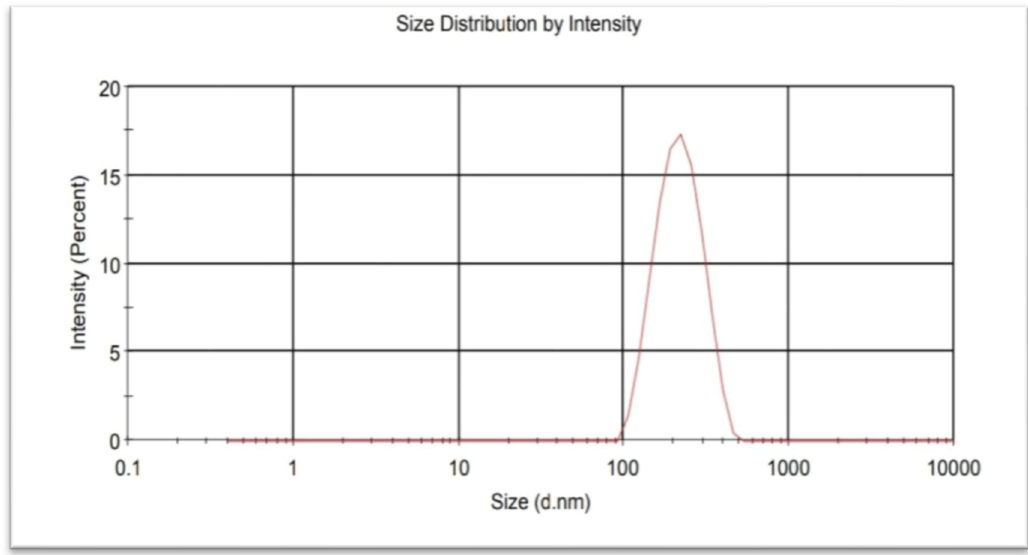
Figure 4. PSA of synthesized IONPs from neem leaf extract.